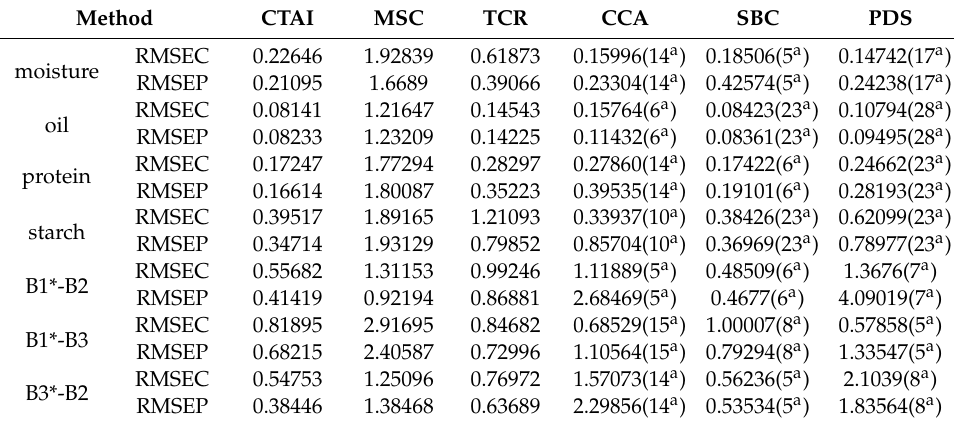
Table 3. Summary of Root Mean Square Error of test set (RMSEP) and Root Mean Square Error of calibration set (RMSEC) of di ff erent methods. The m5spec was used as the master spectra, and the mp6spec was used as the secondary spectra for corn dataset. The protein content was chosen as the property for wheat